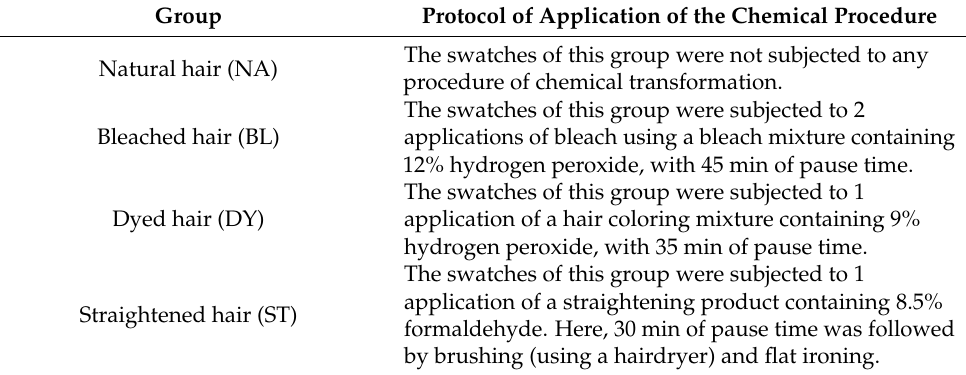
Table 2. Preparation of hair swatches to simulate the four different sensitization levels, performed before each of these groups was exposed to radiation. Group Protocol of Application of the Chemical Procedure The swatches of this group were not subjected to any Natural hair (NA) procedure of chemical transformation. The swatches of this group were subjected to 2 Bleached hair (BL) applications of bleach using a bleach mixture containing